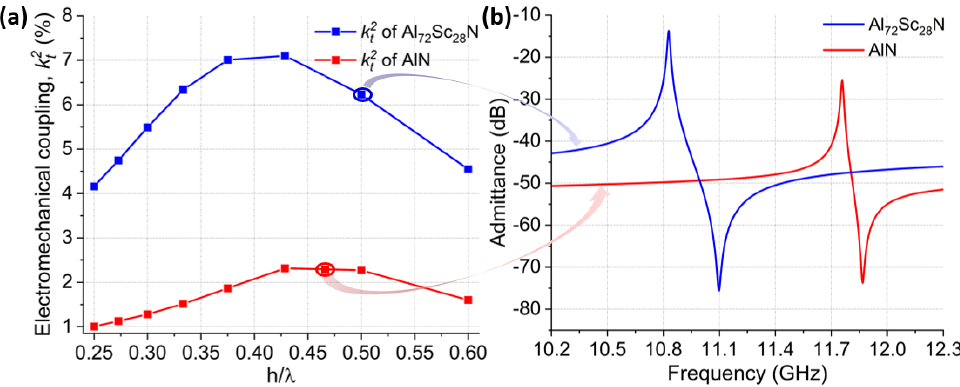
Figure 3. ( a ) Simulated k t 2 of AlN (red) and AlScN (blue) over a range of h / λ x values. ( b ) admit- tance response of AlN and Al 72 Sc 28 N CLMRs operating around 11 GHz with the respective arrows indicating expected k t 2